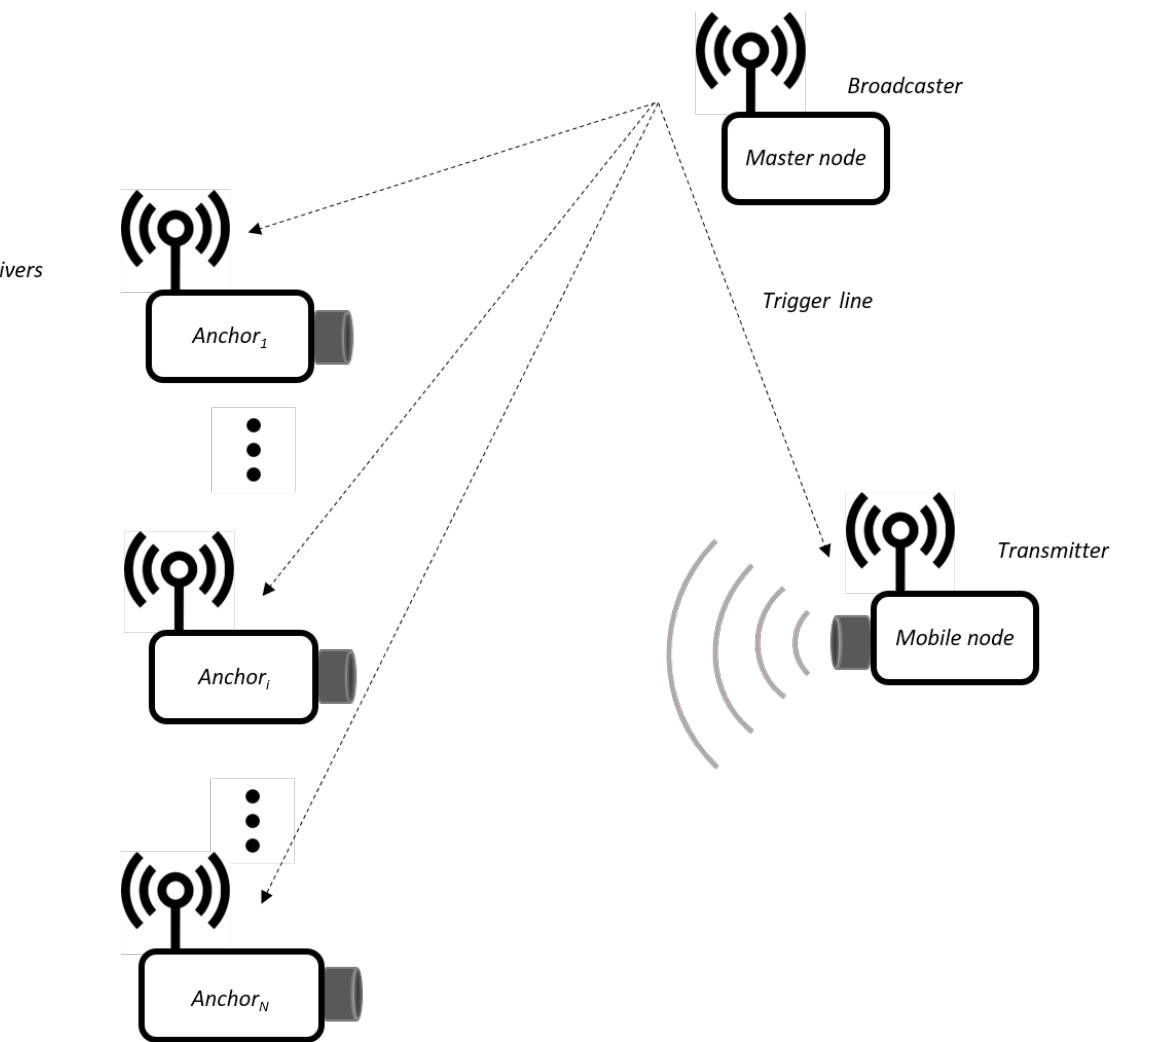
Figure 1. Block diagram of the considered setup.